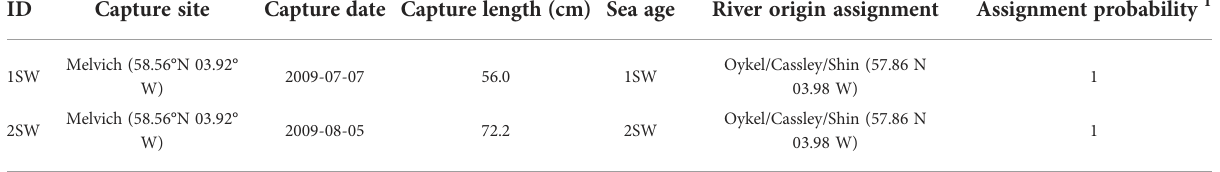
TABLE 1 Capture details and genetic assignment of river or region of origin for individual wild Atlantic salmon used in the